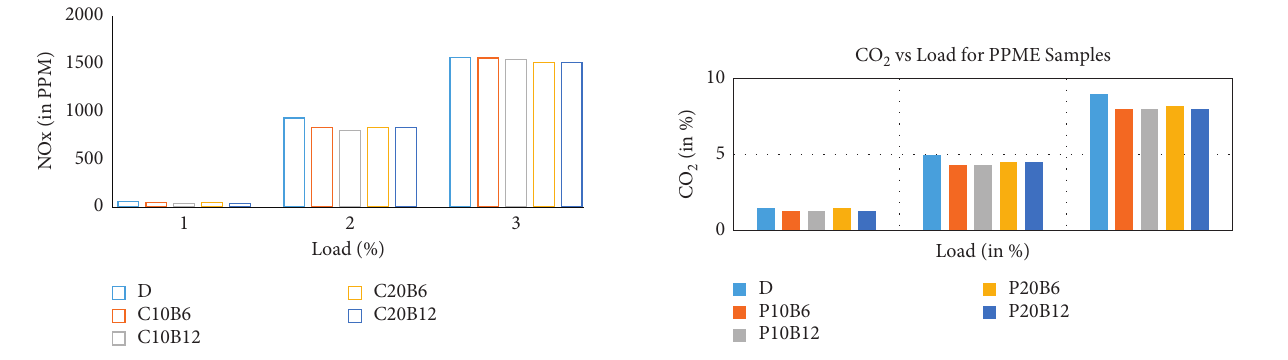
Figure 8: NOx versus load for CIME.